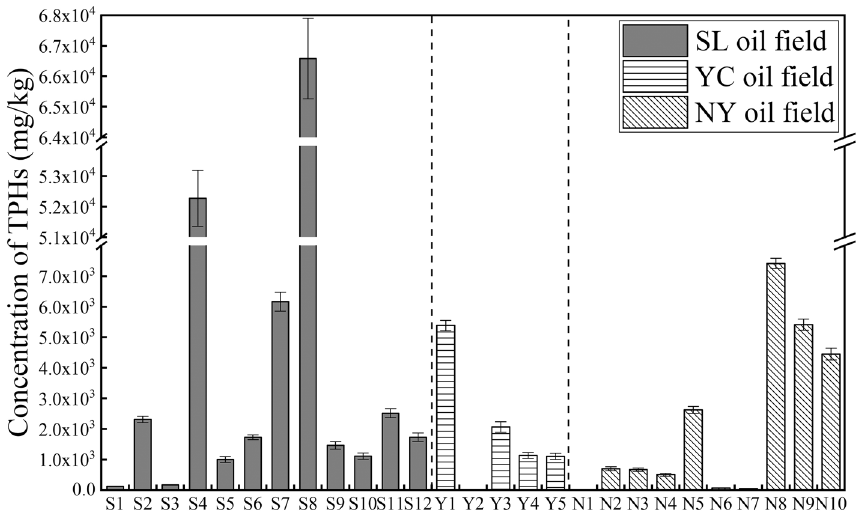
Figure 2. The concentration of TPHs in three oilfield